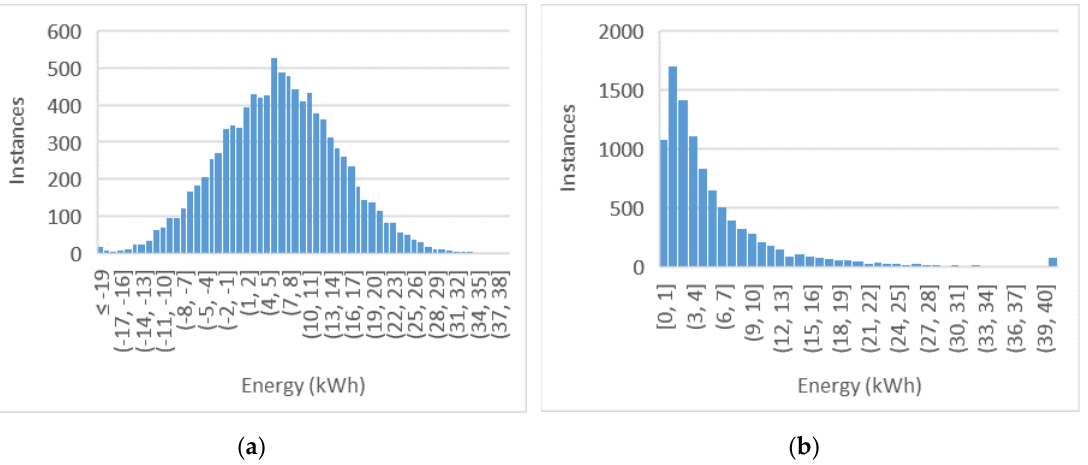
Figure 7. ( a ) Normal distribution energy requirement per charging instance, ( b ) Lognormal distribution